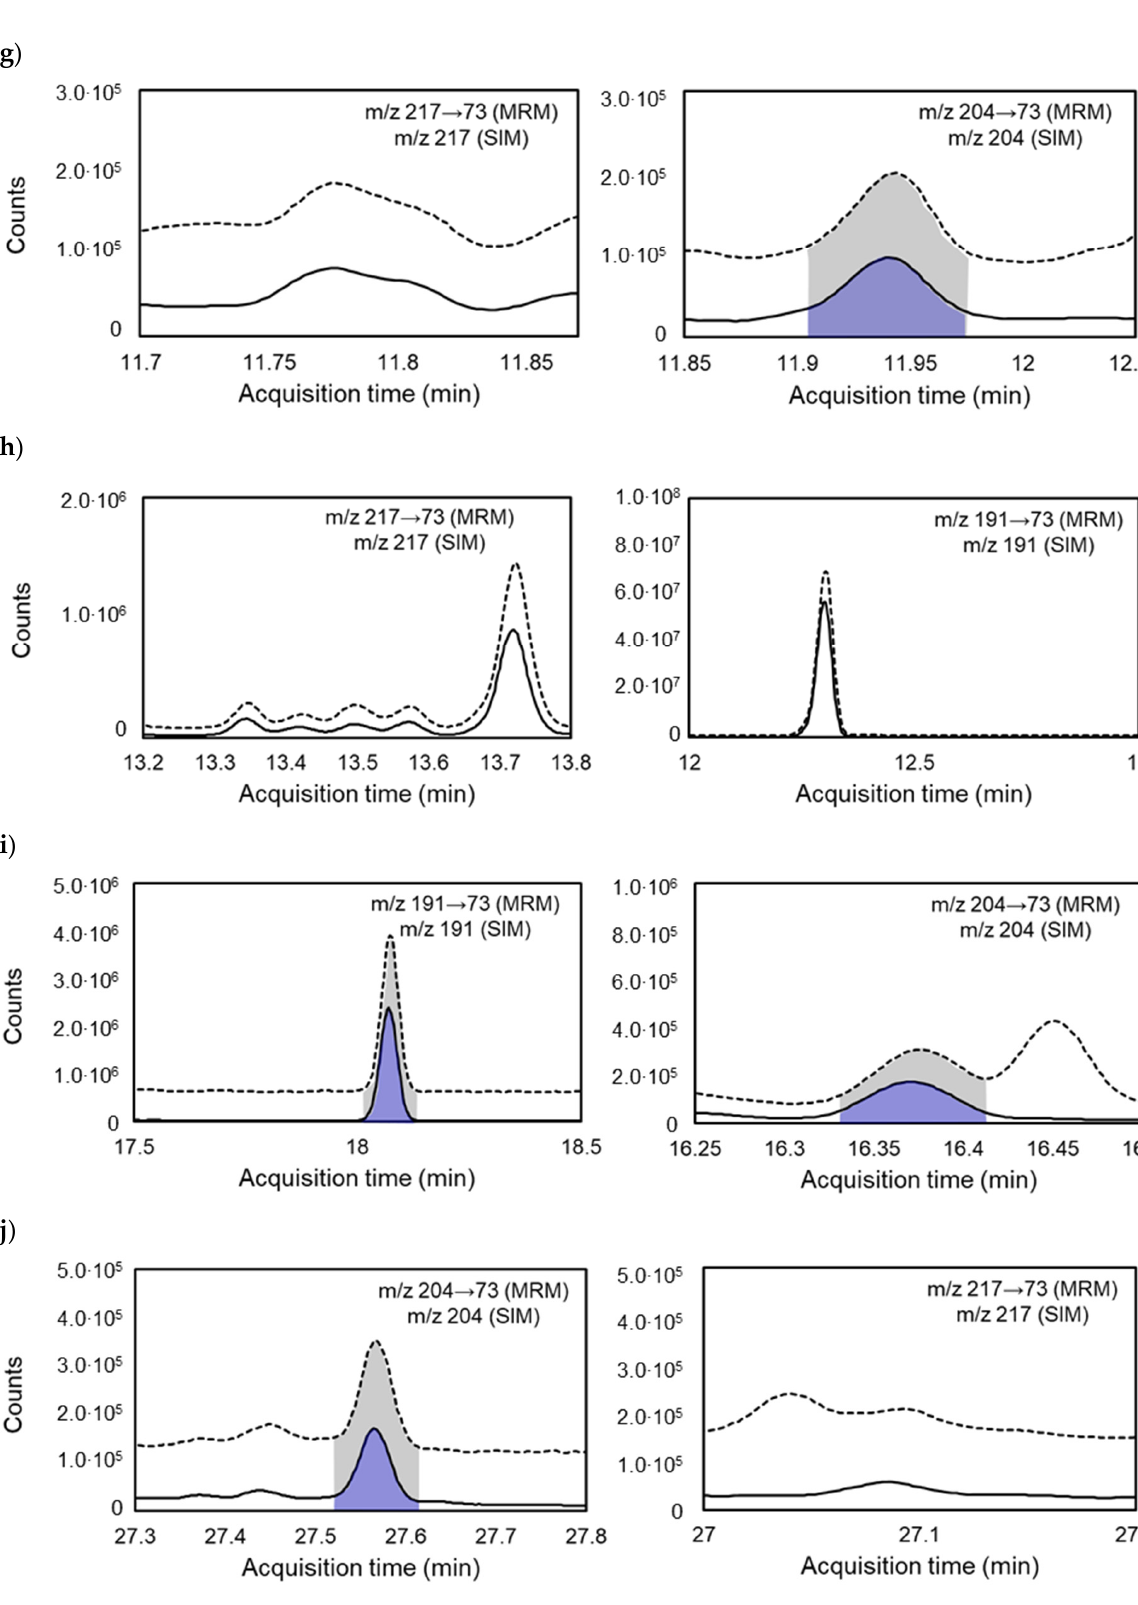
Figure 3. Chromatographic separations obtained using GC-MS/MS in MRM mode (solid line) and GC-MS in SIM mode (dotted line) for ( a ) arabinose, ( b ) levoglucosan, ( c ) fructose, ( d ) mannose, ( e ) galactose, ( f ) sucrose, ( g ) ribose, ( h ) xylose, ( i ) glucose, and ( j ) maltose in sample #11.